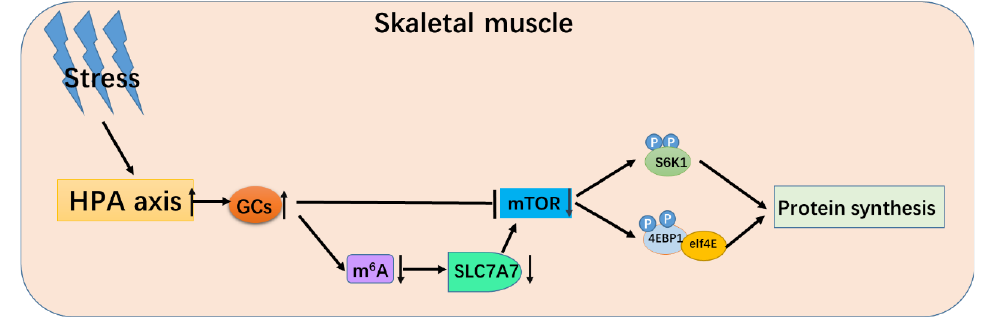
Figure 7. The schematic diagram of glucocorticoid regulating protein deposition process.